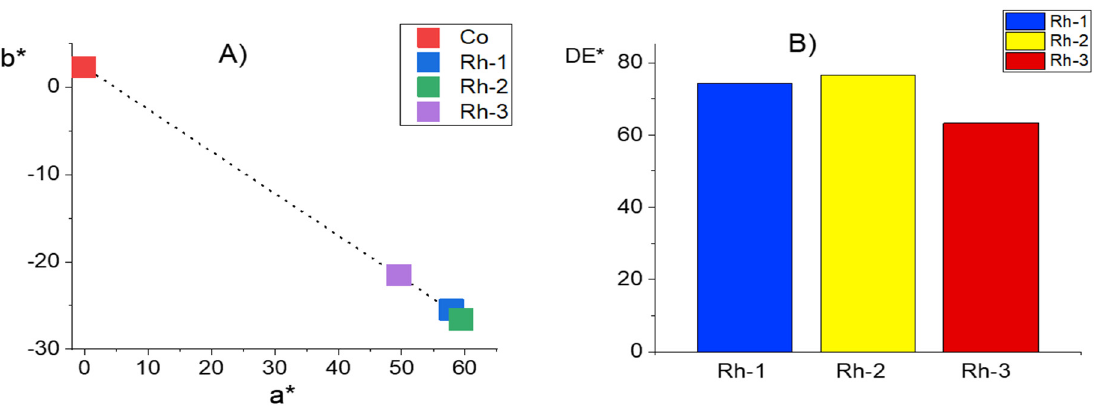
Figure 9. Comparison of the colour coordinates of cotton fabric (Co) and fabrics dyed with Rh-1, Rh-2, and Rh-3: ( A ) color characterization with a* and b* coordinates; ( B ) color difference DE*.